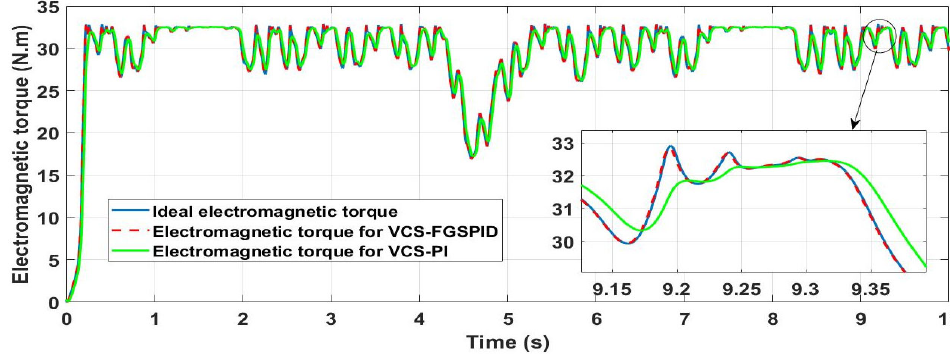
Figure 37. Hardware co-simulation for electromagnetic torque.